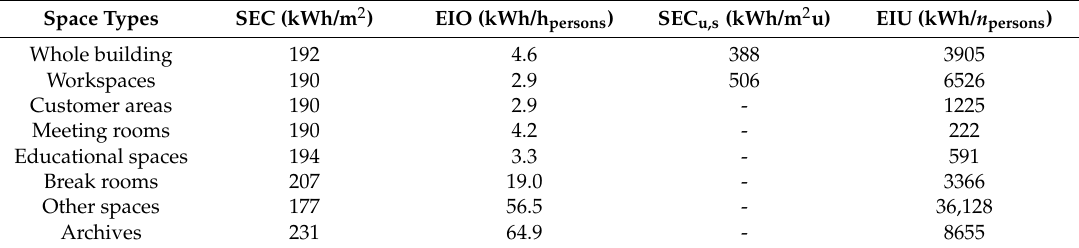
Table 7. Values of energy efficiency indicators for the various spaces before the renovation.